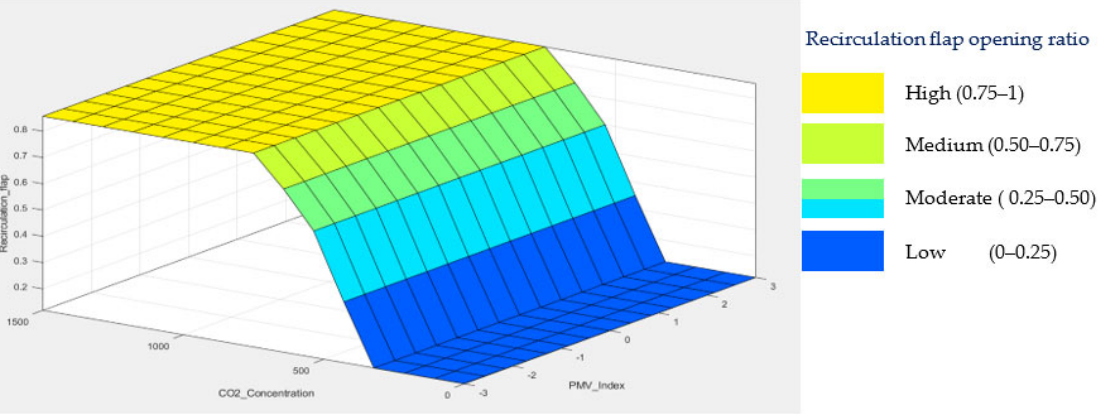
Figure A1. Mapping of the PMV index and cabin temperature membership function to control the HVAC system on/off and mass flow rate.